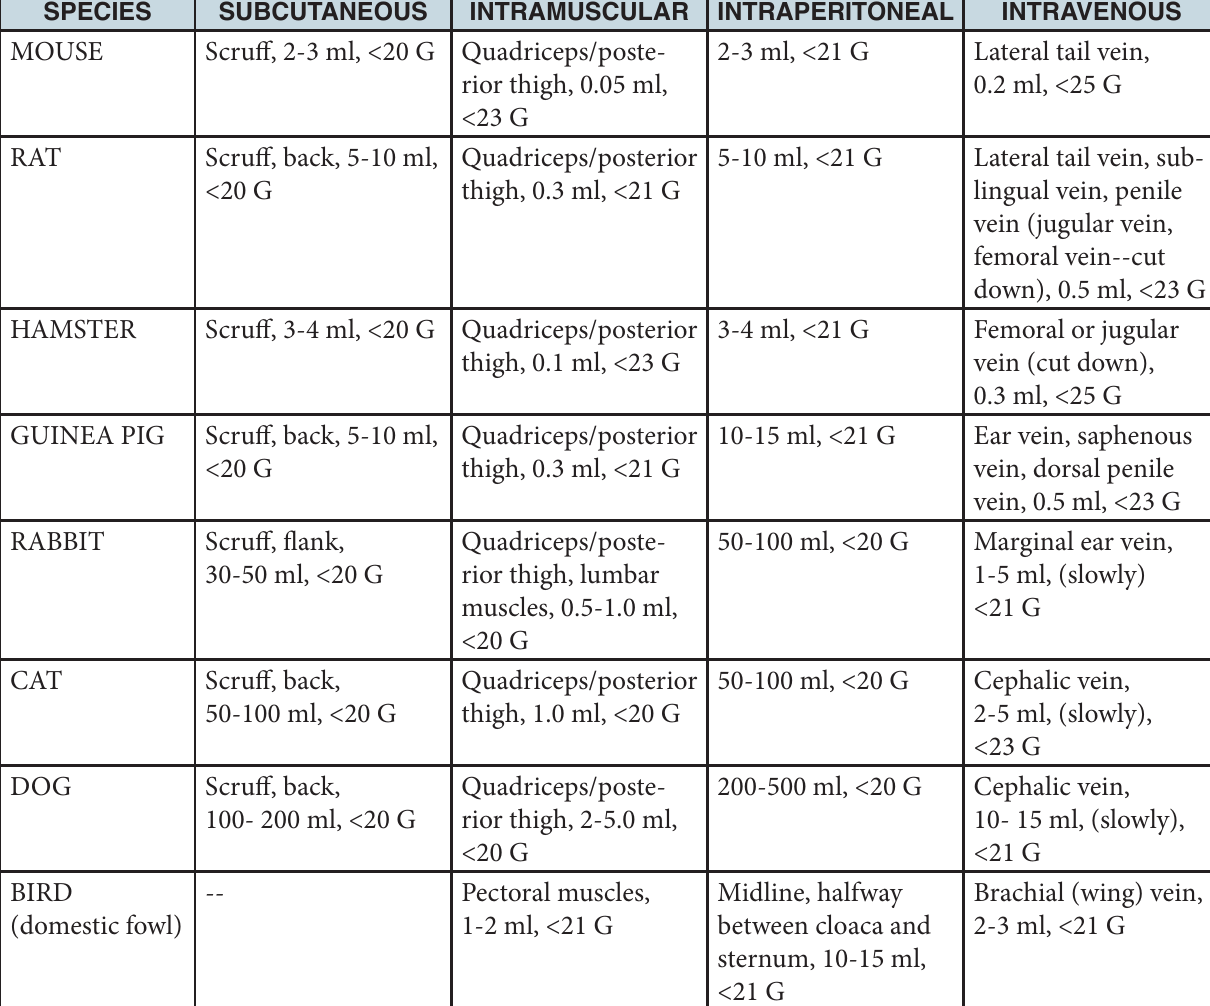
TABLE 1 For Each Species, Site of Injection, Maximum Normally Accepted Volume and Needle